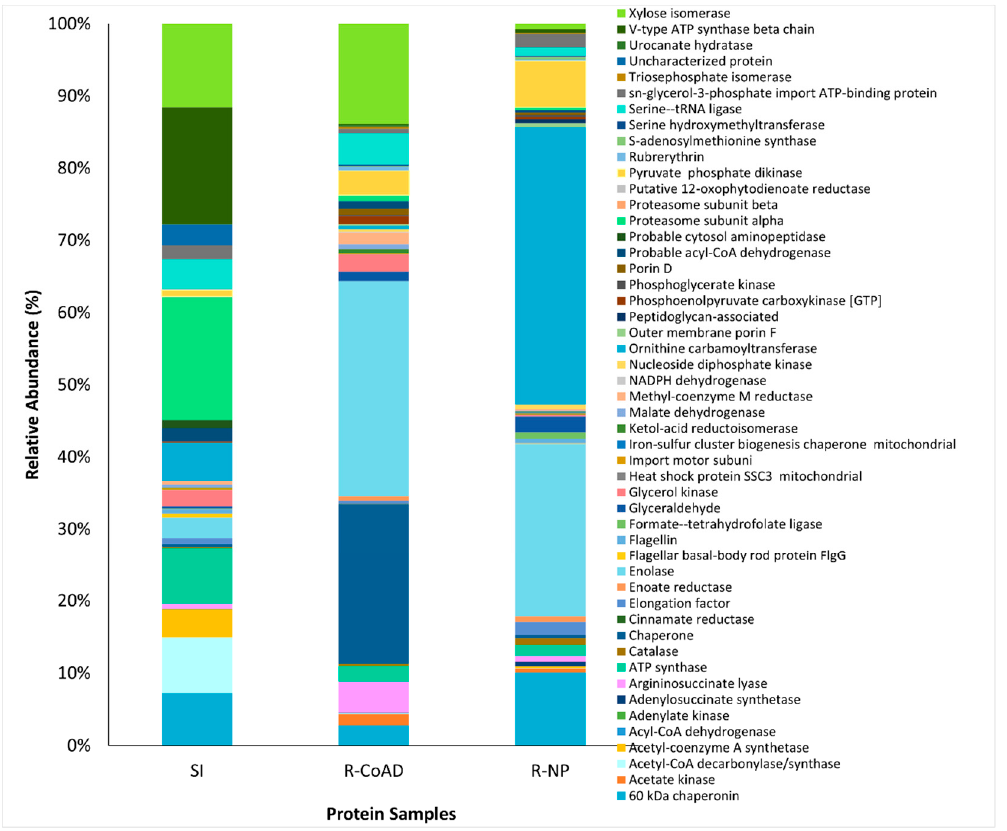
Figure 2. Relative abundance of proteins found in each sample. Average of triplicates. SI: seed inoculum, R-NP: Nanoparticle’s reactor, R-CoAD: Co-digestion reactor.